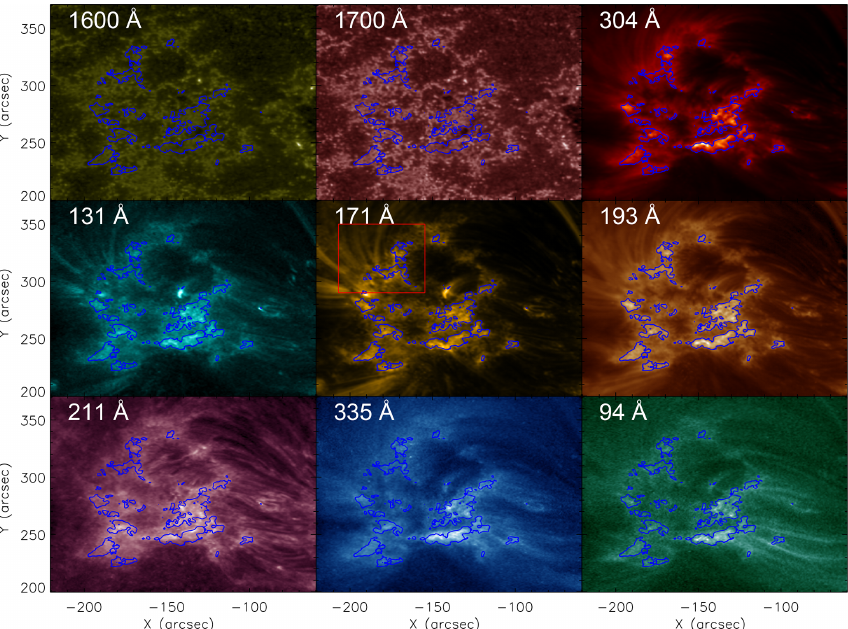
Figure 2. Mosaic representation of the zoomed-in view of the region of interest at different wavelengths of SDO–AIA, as mentioned in the corresponding panels.